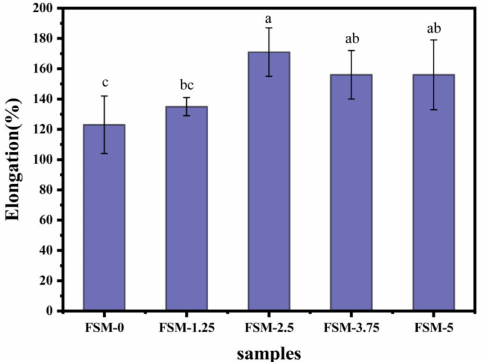
Figure 3. The impact of MAA concentrations on the elongation of composite